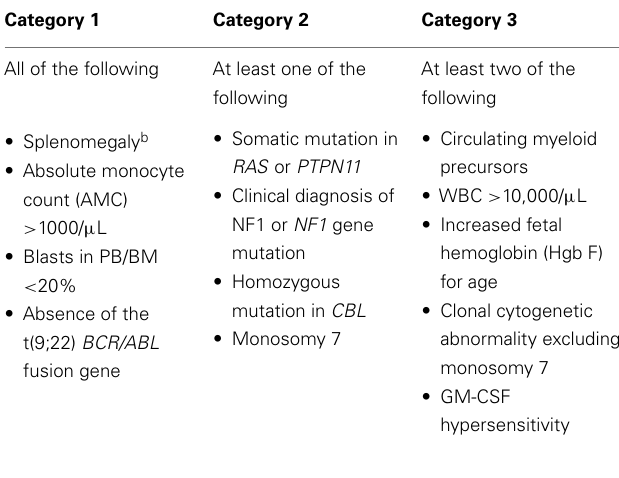
Table 1 | Juvenile myelomonocytic leukemia diagnostic criteria a